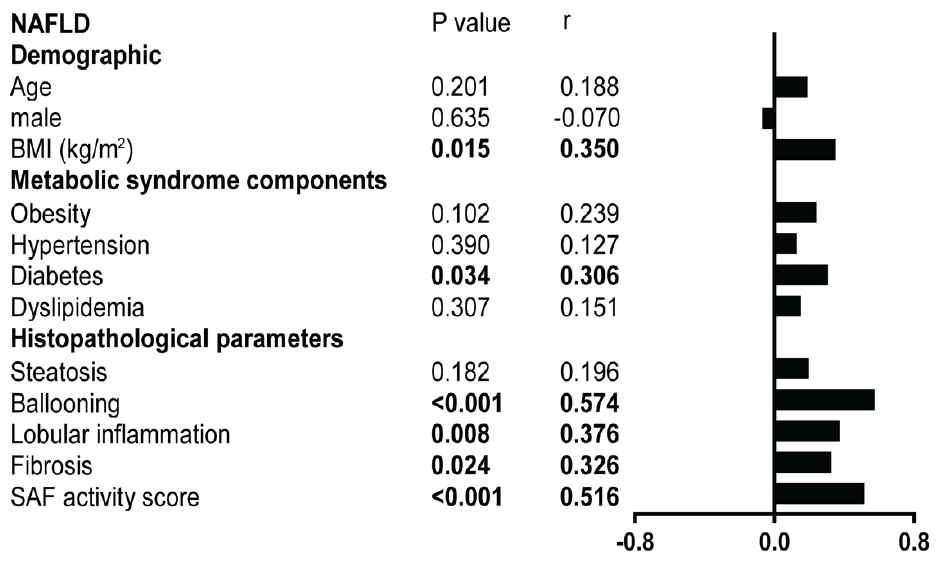
Figure 4. Correlation with demographic, metabolic syndrome features, and histopathological features in NAFLD ( n = 48). The left panel presents Pearson correlation coefficient r and p -values for each variable. The right panel/vertical histogram shows different r levels for each variable with PLA dots/cell. SAF scores were adopted for histological parameters.